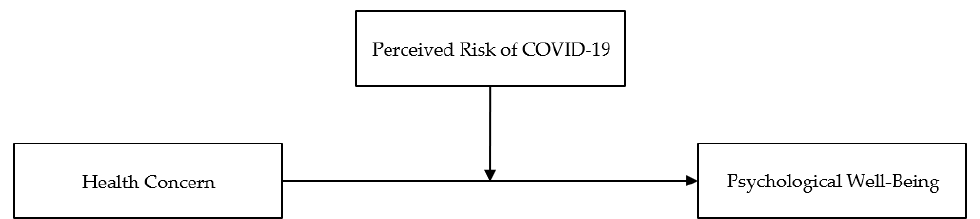
Figure 1. Conceptual framework of the relationship between health concern and psychological well-being, and the moderating role of perceived risk of COVID-19.